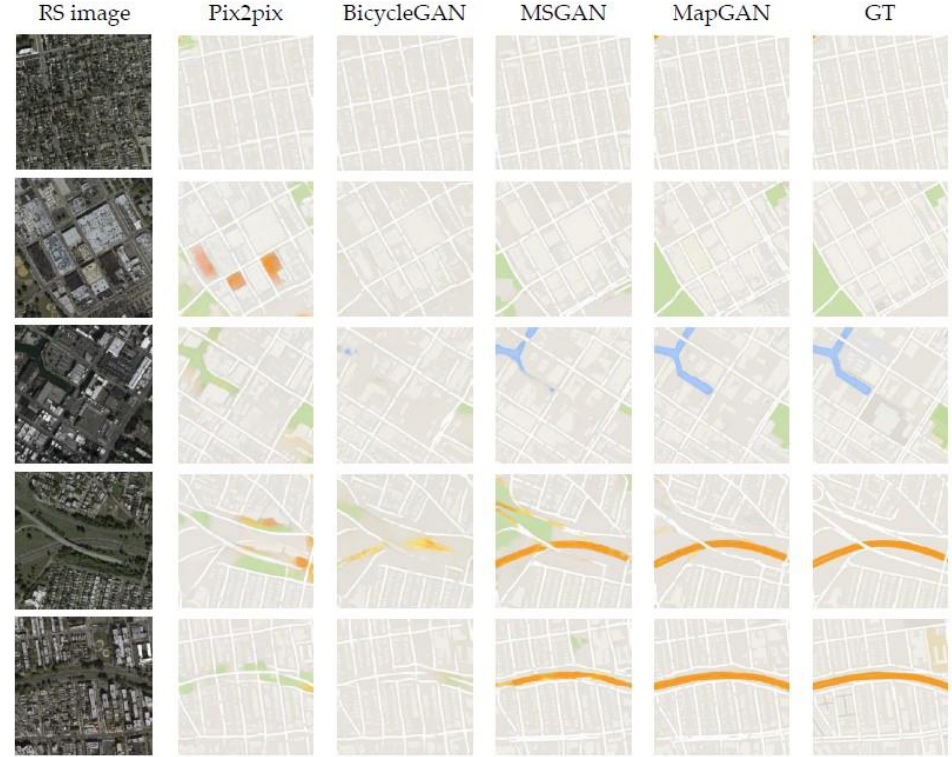
Figure 9. Comparison results of MapGAN and some other image translation models in the one-to-one domain map generation experiment to generate Google maps. The images from left to right are remote sensing images and the Google maps generated by MapGAN, Pix2pix, BicycleGAN, the MSGAN, and MapGAN, the real Google maps.